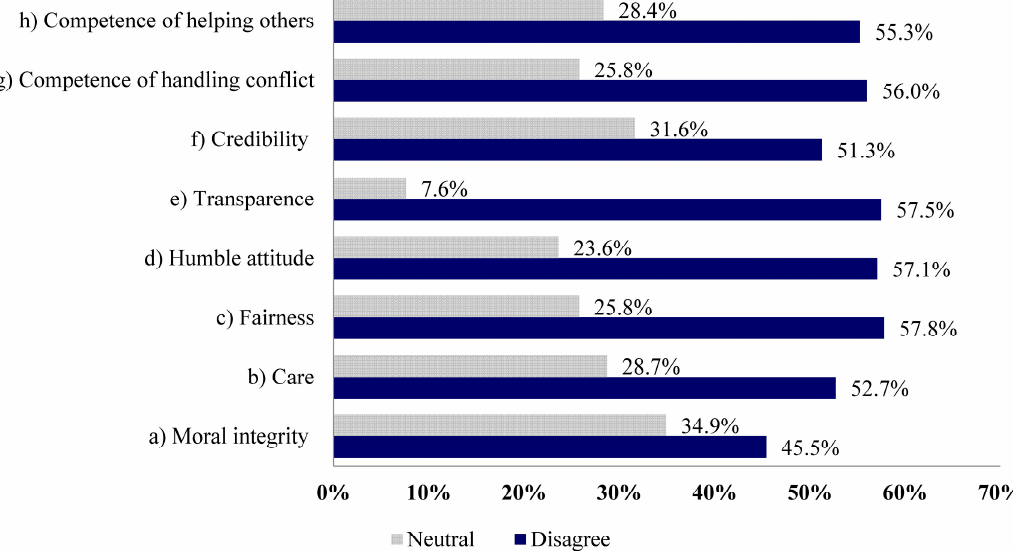
Table 4. Trust levels in relation to demographic characteristics.